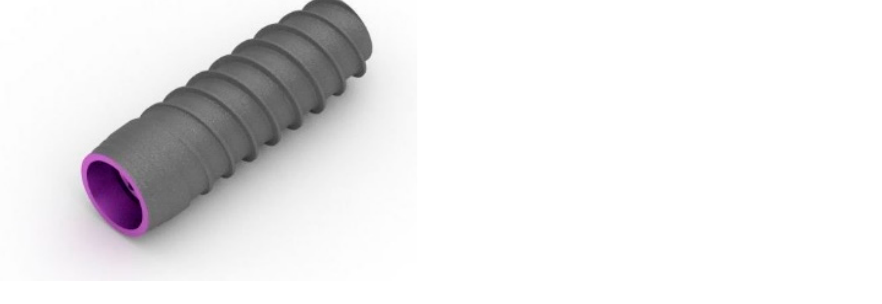
Figure 1. Bone level dental implant studied. This design was manufactured from grade 4 titanium and Ti6Al4V.